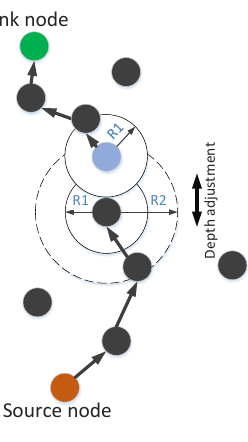
Figure 4. Depth adjustment.